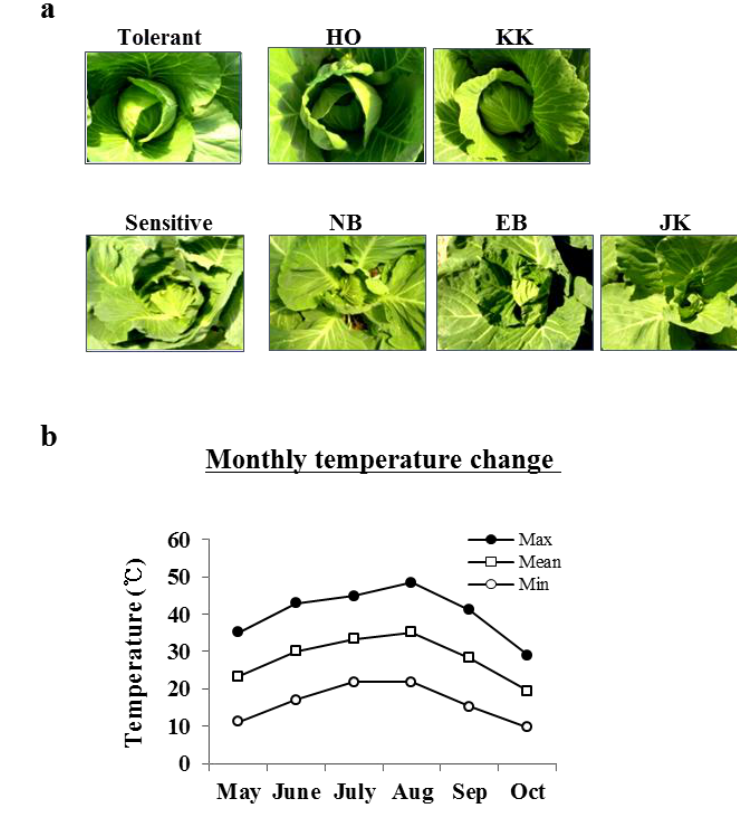
Figure 1. Heat stress phenotype of cabbage head formation after summer season. These photos were taken after the summer season had passed. ( a ) Phenotypes of inbred lines HO, KK, NB, EB and JK (Asia Seed Company). The HO and KK lines showed heat tolerance, whereas the NB, EB and JK lines showed heat-sensitive phenotypes in the field condition. A heat-tolerant cultivar and a heat-sensitive cultivar were used as a positive or negative control of heat shock stress in the field condition. Seeds were sown in May, and young plants were transplanted in June. Photos were taken at the end of October; ( b ) Temperature changes during cultivation of cabbages in a vinyl house in the field condition are shown. Max, maximum temperature; Mean, average temperature; Min, minimum